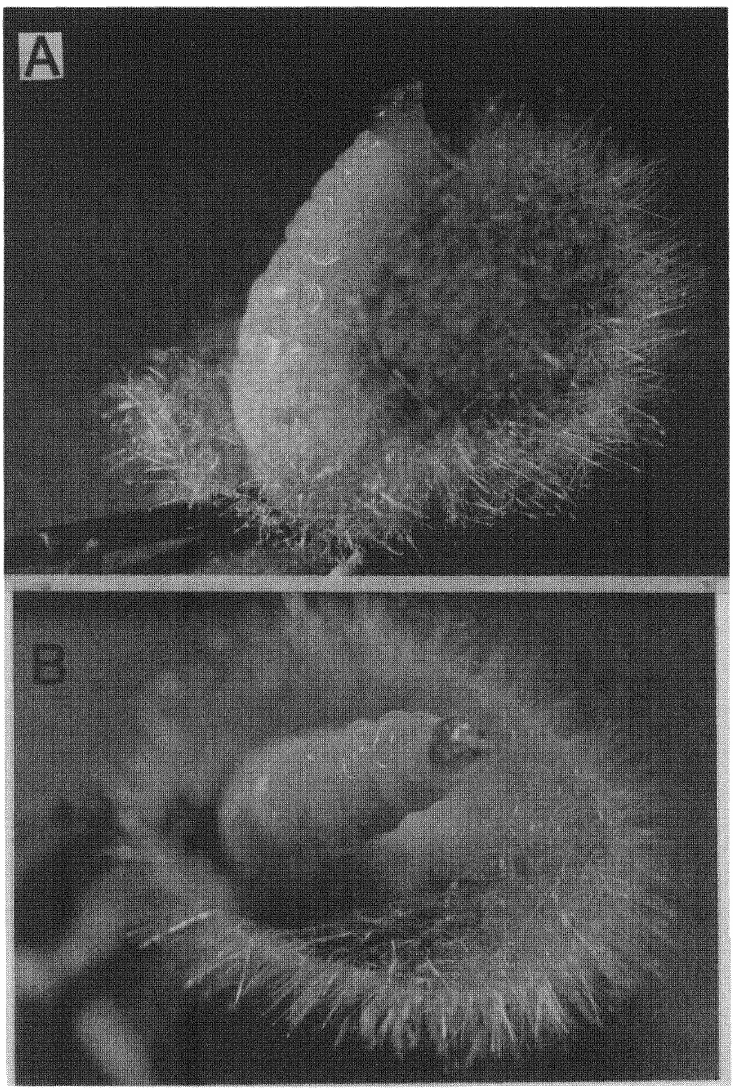
Fig. 6. A & B, larva of A. azureus spinning outer